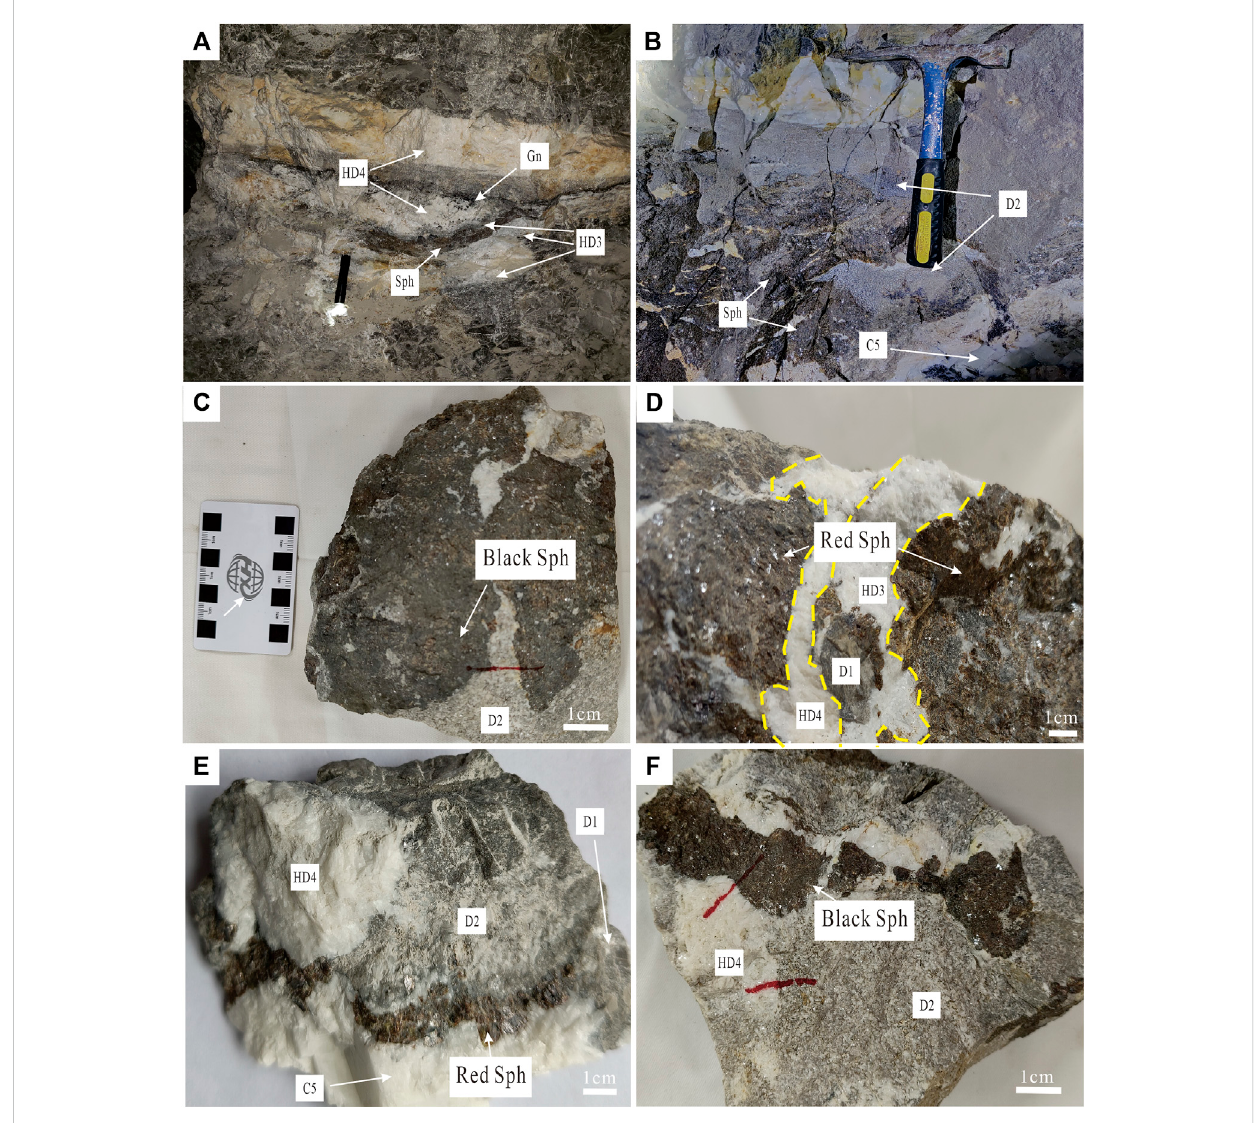
FIGURE 3 Photographs of fi eld and specimens from the Fuli Pb-Zn deposit. (A, B) Bulk Sp and/or Gn are cemented by Dol/Cal veins. (C) Massive black sphalerite. (D) Massive red sphalerite. (E) Black sphalerite veins fi lled in dolomite fi ssures. (F) Black sphalerite breccia in hydrothermal dolomite vein.